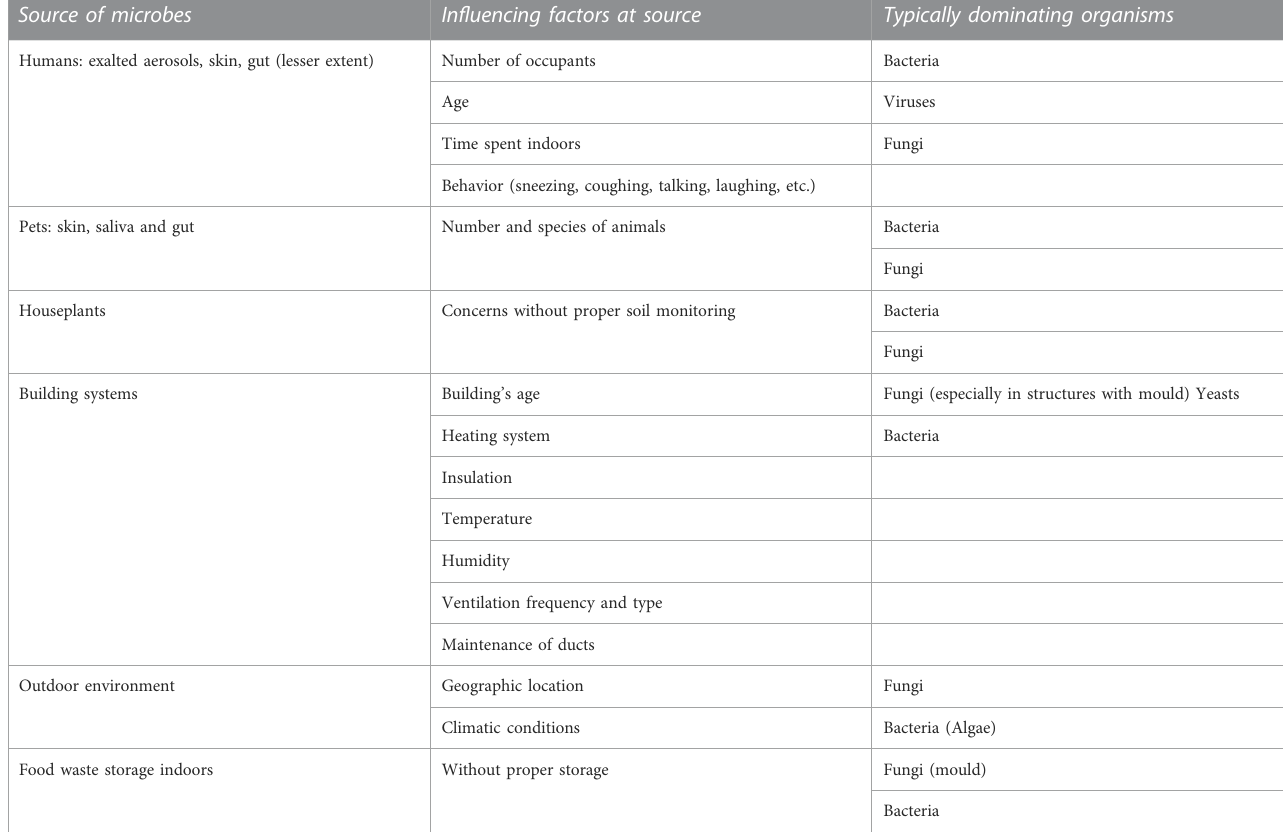
TABLE1Commonmicrobialsourcesofsurfacesandairintheindoorenvironment.Thefeaturesofthebuilding,thebuilding ’ soccupants,andtheoutdoorenvironment affect the species and prevalence of the microbial organism (Prussin and Marr, 2015; Kumar et al., 2021). Fungal contamination with spores and mycotoxins,